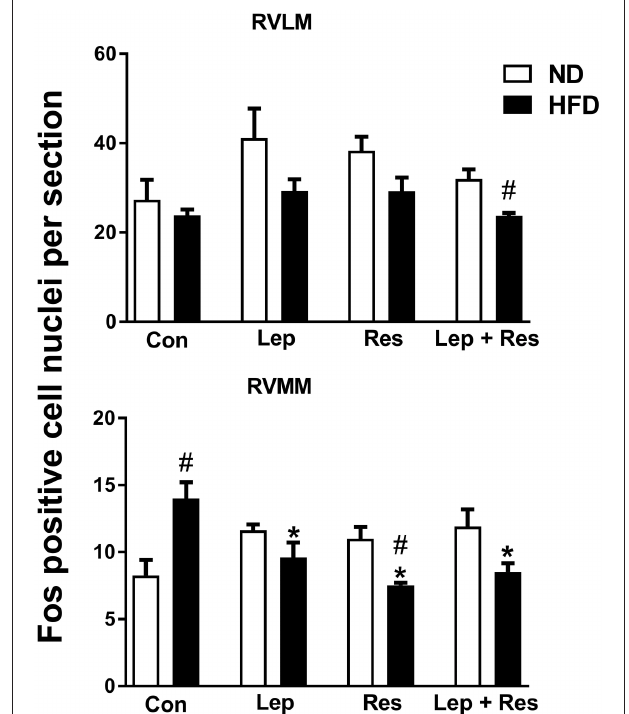
FIGURE 5 | Numbers of Fos-positive cell nuclei counted unilaterally per section in the nucleus of the solitary tract (NTS) and Raphe pallidus nuclei (RPA) from rats fed a normal chow (ND) and a high fat diet (HFD) administered intracerebroventricular saline (control, n = 4 ND, n = 4 HFD; 5 µ l), leptin ( n = 4 ND, n = 5 HFD; 7 µ g in 5 µ l), resistin ( n = 4 ND, n = 4 HFD; 7 µ g in 5 µ l), or leptin combined with resistin ( n = 5 ND, n = 6 HFD). # 0.01 < p < 0.05 HFD compared to ND in the NTS; # 0.005 < P < 0.05 HFD compared to ND in the RPA; + P < 0.05 and P < 0.01 hormone alone compared with leptin + resistin for NTS and RPA respectively.